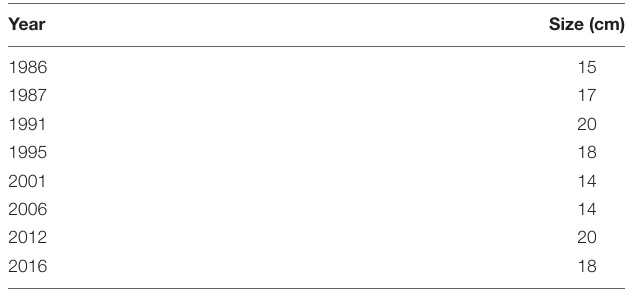
TABLE 5 | Changes in minimum landing size (MLS) regulations for bluefish in Turkey*.